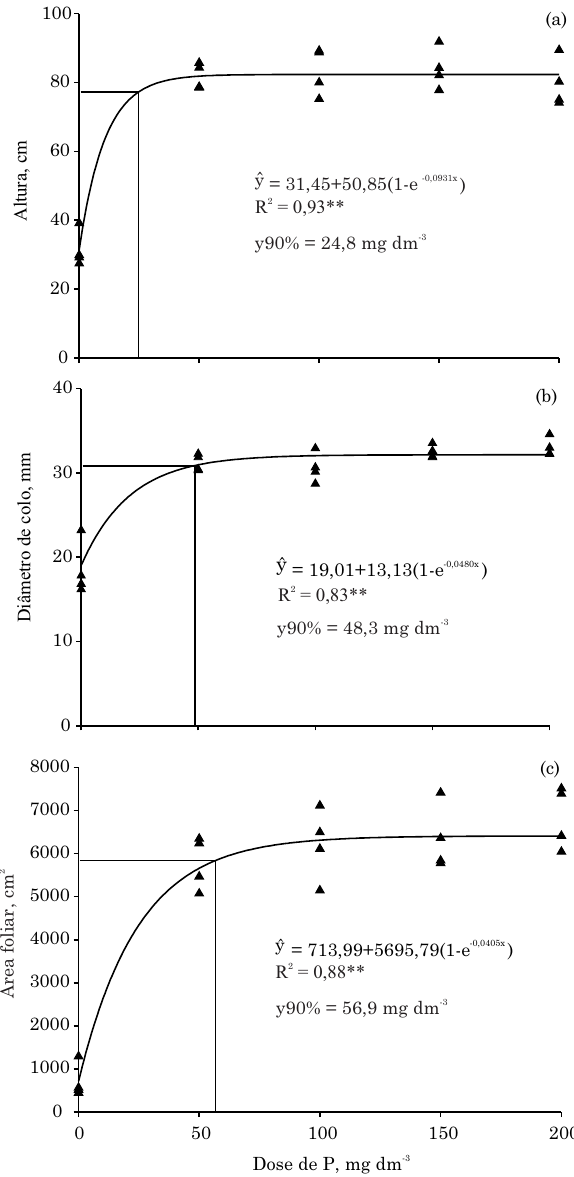
Figura 2. Altura (a), diâmetro de colo (b) e área foliar (c) de plantas de pinhão-manso em função de doses de P, 150 dias após o transplantio. ** significativo a 1